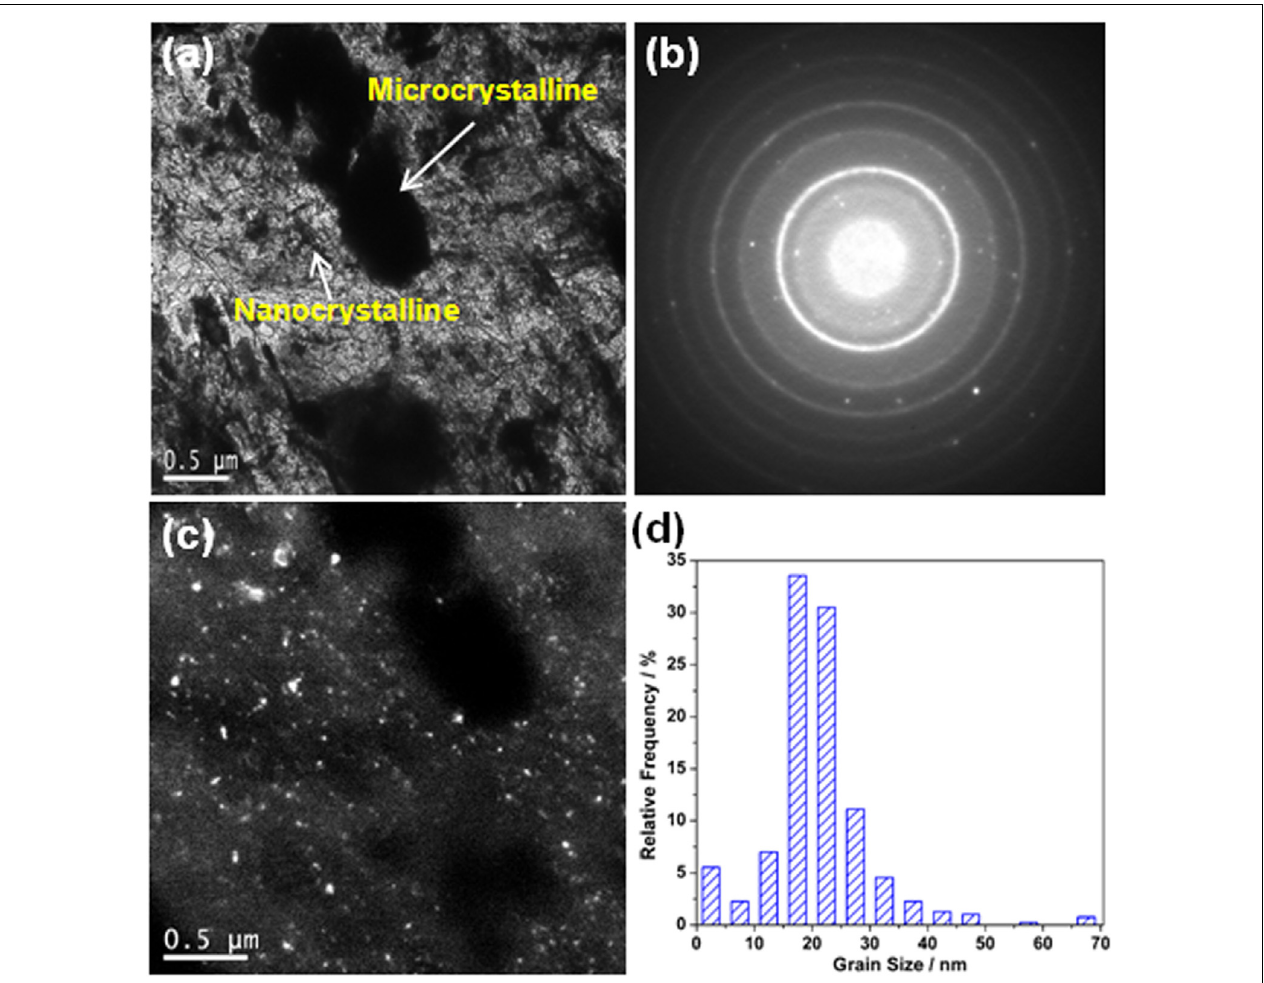
FIGURE 8 | Transmission electron microscope results of the 2205 DSS prepared with the excessive Fe 2 O 3 of 5.0%: (a) bright-field image, (b) selected area electron diffraction, (c) dark-field image, and (d) size distribution of the crystal